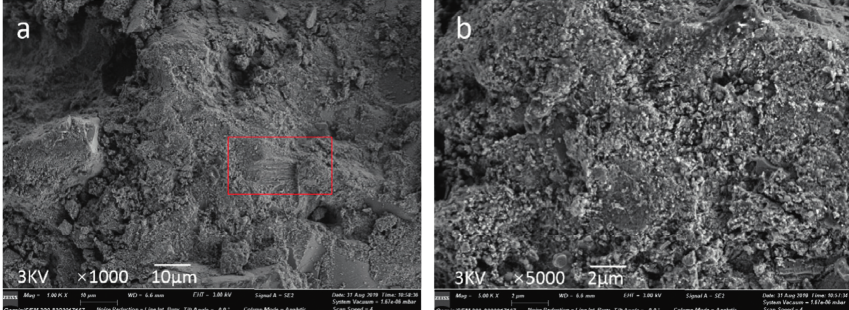
Figure 6: SEM micrographs showing the morphology specimen b4 at 1000x (a) and 5000x (b) magnification.